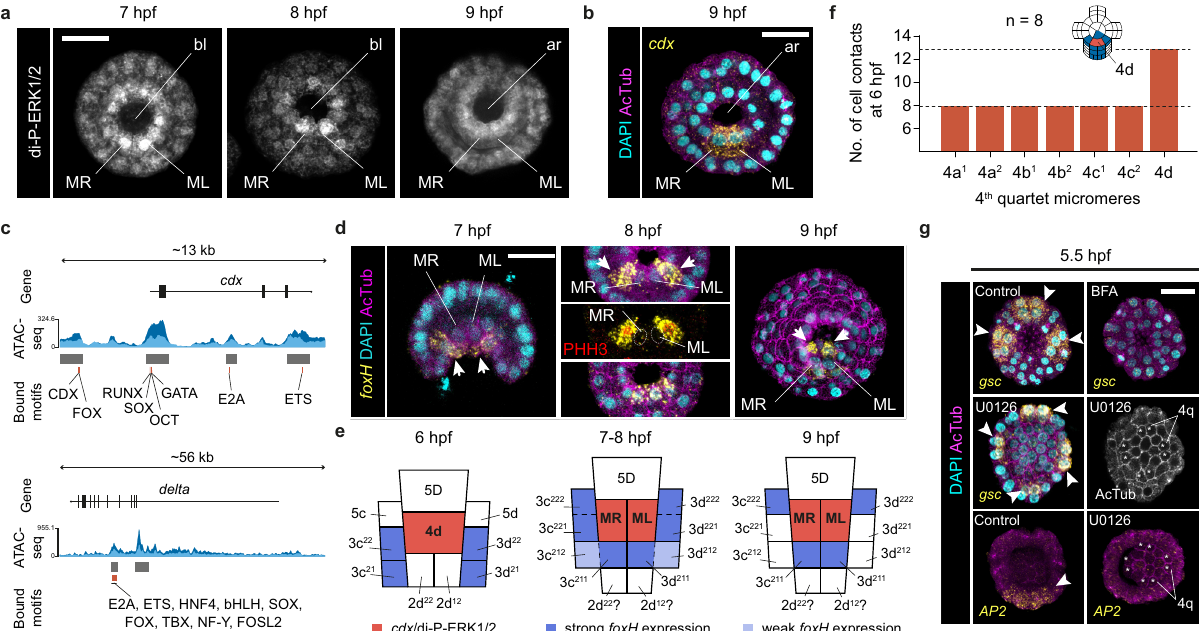
Fig. 6 The behaviour of 4d during gastrulation. a z-stack projections (vegetal views) of whole mount immunohistochemistry against di-phosphorylated ERK1/2 (di-P-ERK1/2) from 7 to 9 h post fertilisation (hpf). The 4d micromere cleaves at 7 hpf into the MR and ML daughter cells (Supplementary Fig. 1). b z-stack projection (vegetal view) of a fl uorescent whole mount in situ hybridisation against cdx (yellow) at the gastrula stage (9 hpf), counterstained with DAPI (nuclei) and acetylated tubulin (cell boundaries). c Distribution of transcription factor motifs accessible in open chromatin regions around the cdx (upper part) and delta (lower part) loci at 5 hpf. Dark and light blue depict the two ATAC-seq replicates. d z-stack projections (vegetal views) of fl uorescent whole mount in situ hybridisations against foxH from 6 to 9 hpf (i.e., gastrulation), counterstained with DAPI (nuclei), acetylated tubulin (cell boundaries) and phospho-Histone3 (red; marker of mitosis). e Schematic drawings of the cells surrounding 4d and MR/ML during gastrulation,